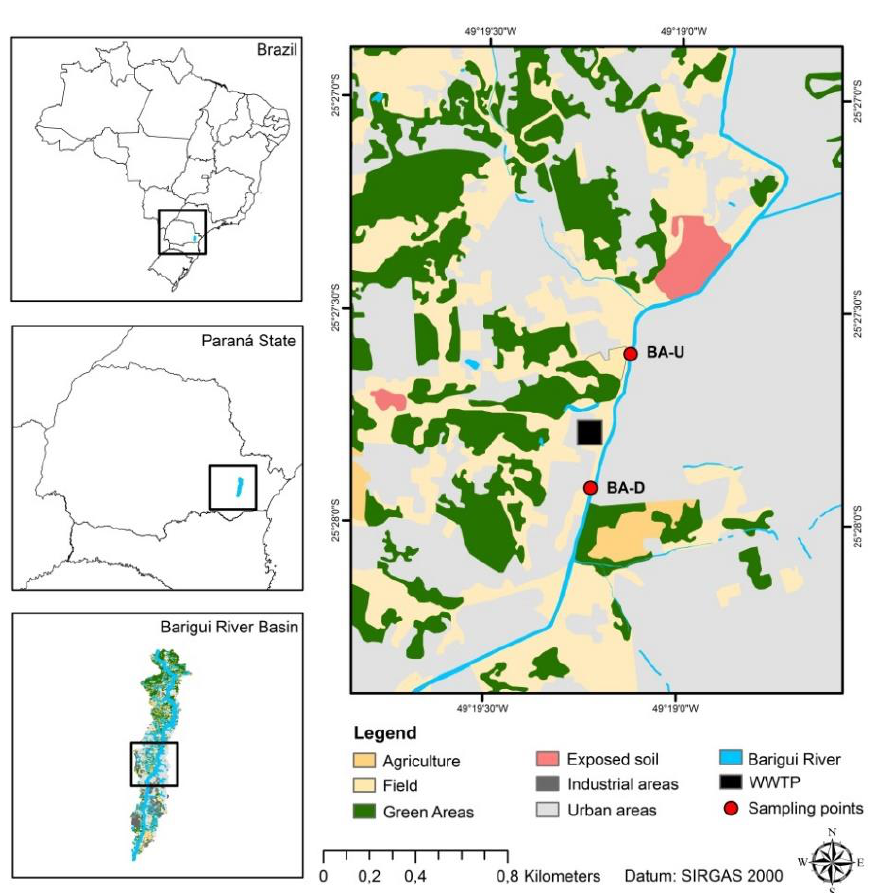
Figure 1. The Barigui River Basin, land use and location of the Santa Quitéria WWTP, and the upstream (BA-U) and downstream (BA-D) sampling points in the Barigui River.